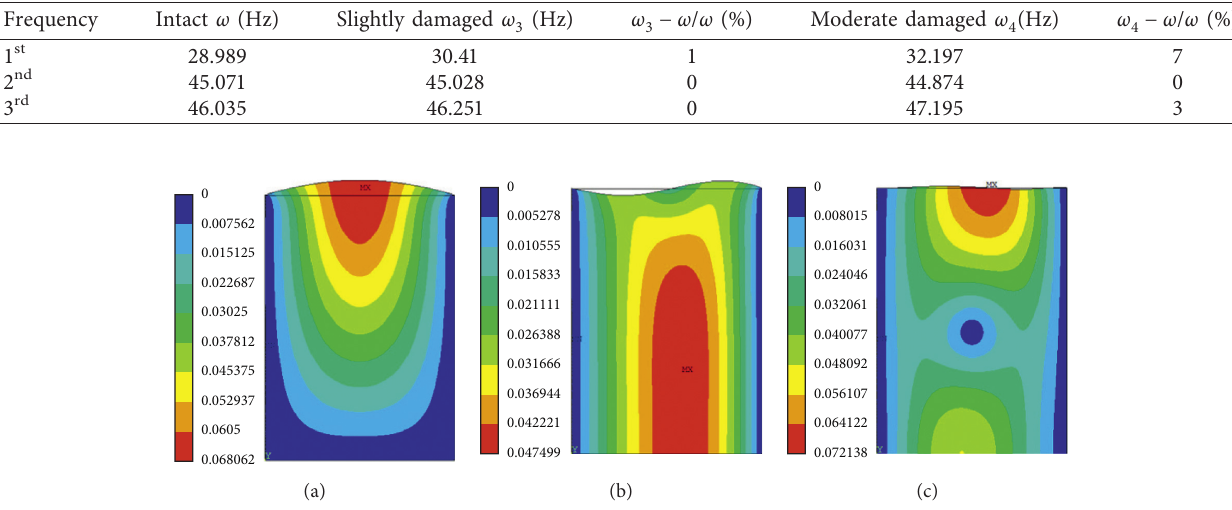
Figure 4: Shapes of the first three modes of the slightly vertically damaged polymer cutoff wall. (a) First vibration mode. (b) Second vibration mode. (c) Third vibration mode.